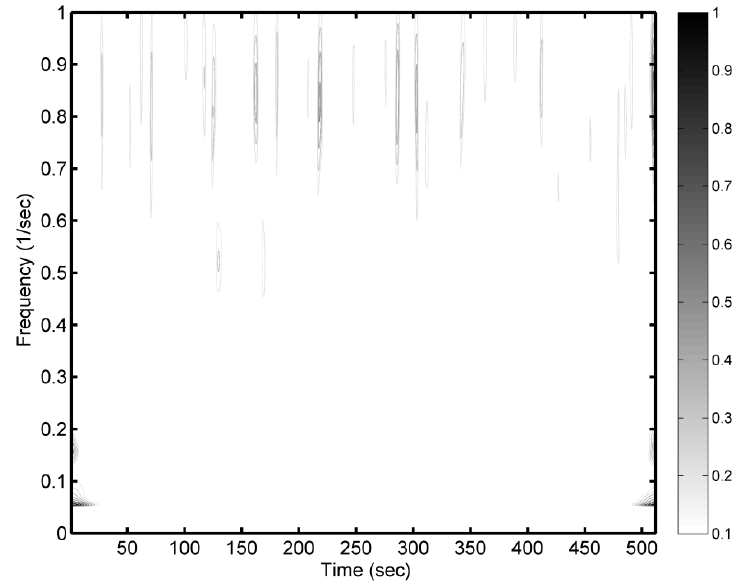
Figure 2. The normalised differences between two wavelet spectra of sea surface elevations. One was directly calculated from an observational sea surface elevation record, and the other wavelet spectrum was estimated from the synthetic acceleration data which was derived from the same observational record of sea surface elevations by means of double forward difference. To estimate the wave spectrum of sea surface elevations from the synthetic acceleration data, the transfer function in Equation (13) was applied here. The normalised difference was their differences of two wavelet spectra divided by the maximum difference